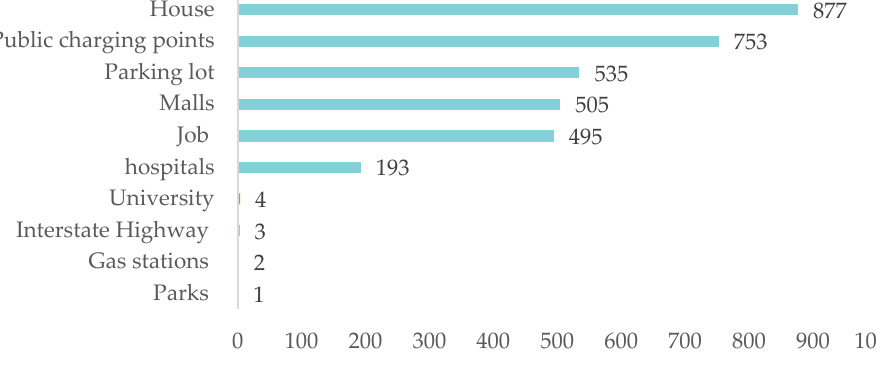
Figure 9. Preferred places by users for EV recharges.